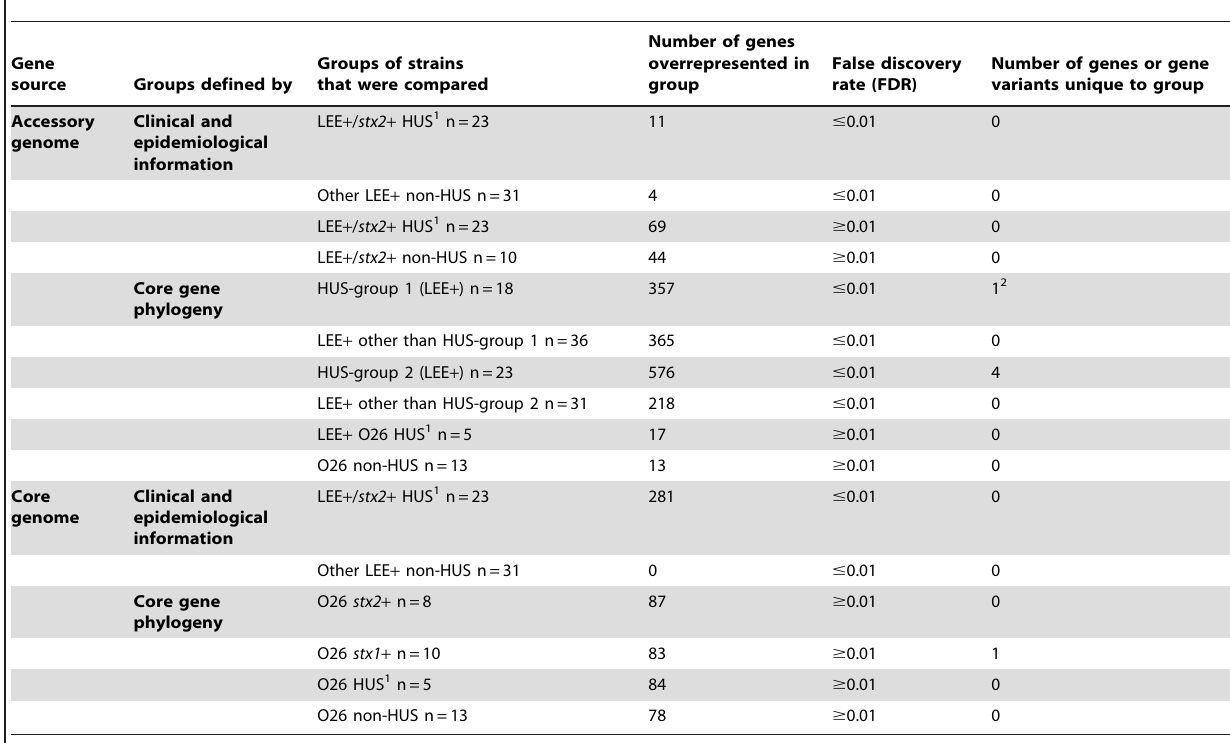
Table 2. Overview of the different subgroups of STEC that were compared in this study.